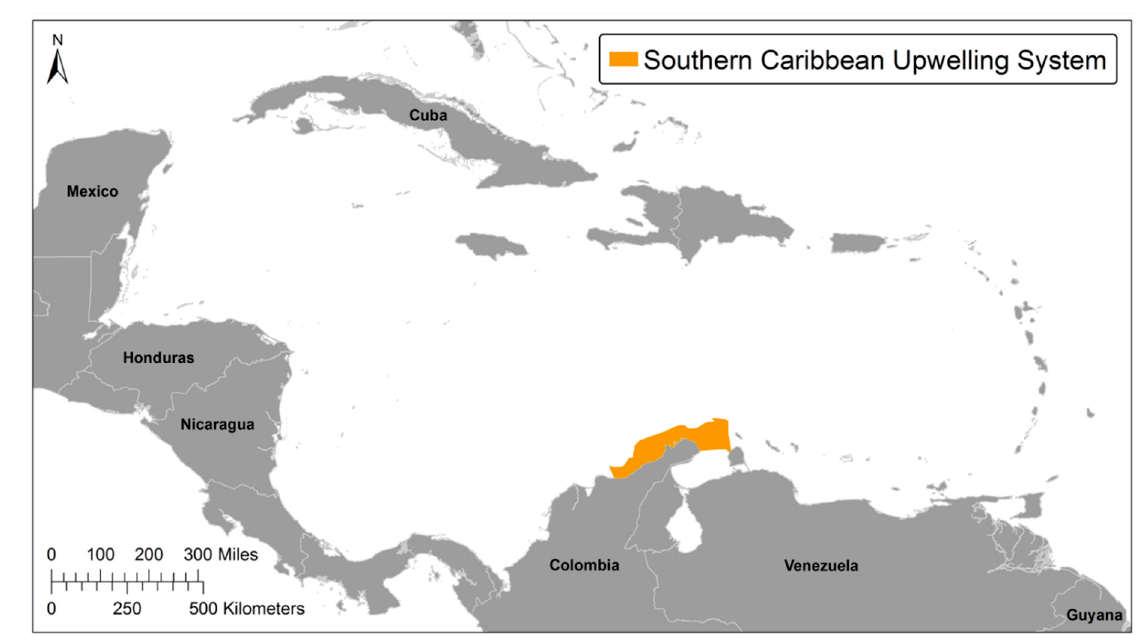
Figure 1. Southern Caribbean Upwelling System by the Colombian peninsula of La Guajira (in orange) (10–12.5°N 63–65°W) in the Central Caribbean Ecoregion (14°31’19” N, -75°49’3” W) of the Tropical Western Atlantic.